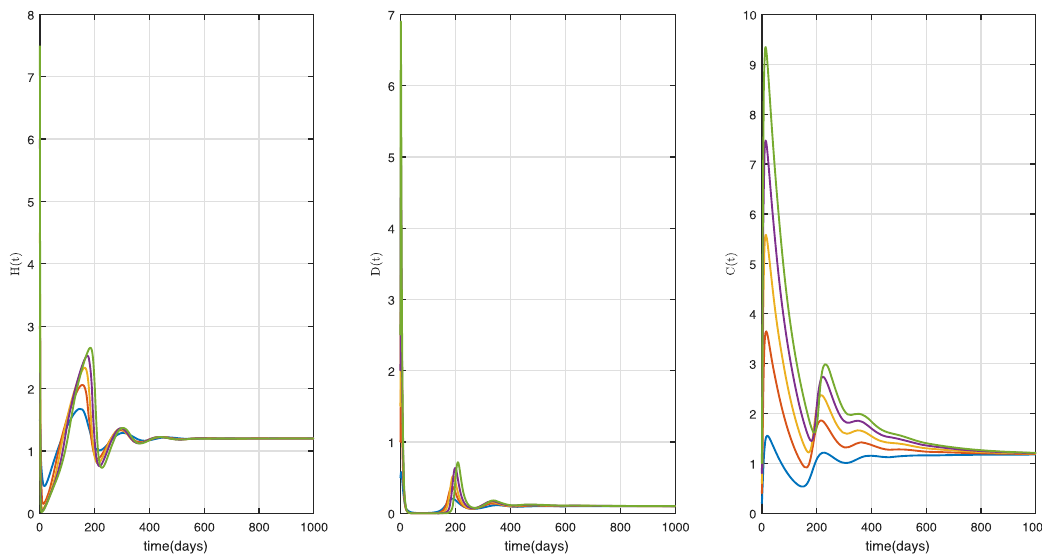
and (cid:3) = > 4.8346 1 1 . There is 0